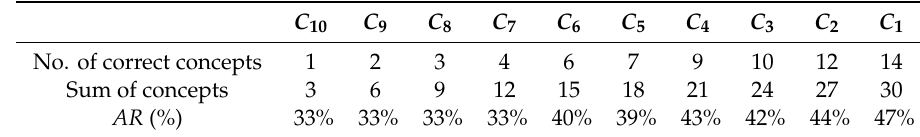
Table 12. Learning achievement results for student 5, who correctly answered Q 1 , Q 3 , Q 4 , Q 6 , Q 9 , Q 10 , Q 12 , Q 14 , Q 16 , Q 18 , Q 21 , Q 24 , Q 26 , and Q 30